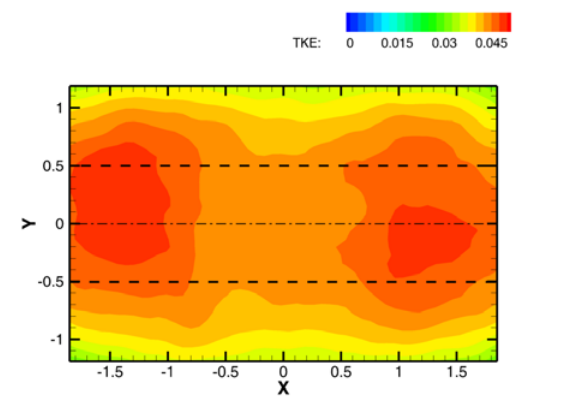
Fig. 3. TKE distribution .